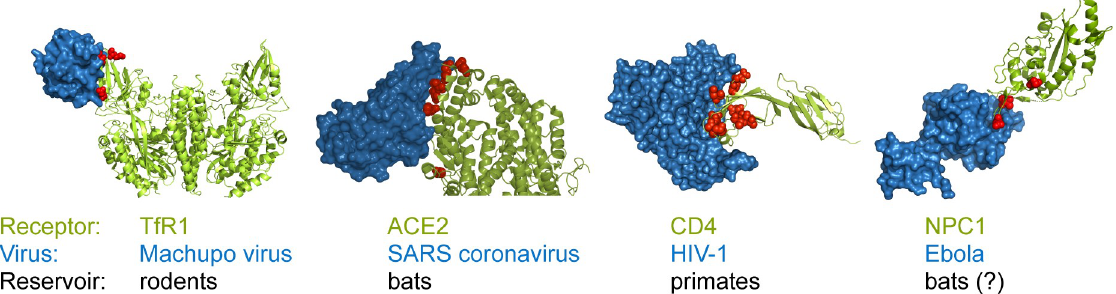
Fig 2. Receptors used by viruses are under positive selection at the host–virus interaction interface. The cocrystal structures are shown for four human cellular receptors (green) in complex with the surface glycoproteins (blue) of four viruses that use these receptors to enter cells. In each case, we analyzed the evolution of the receptor gene throughout the speciation of the animals that have served as long-term reservoirs for each of these viruses (rodents, bats, and primates in these four cases). In those analyses, amino-acid positions in the receptors that are evolving under positive selection (dN/dS > 1; red spheres) were identified that mapped directly to the interaction interface with the indicated viruses [93–96].These residue positions are rapidly evolving, which means that each species within these animal groups tends to encode unique amino acids at these positions. This explains why viruses often have to accumulate mutations in their surface glycoprotein that allow them to use the version of their receptor in a new species. Cocrystals shown are TfR1 (PBD: 3KAS [103]), ACE2 (PDB: 2AJF [104]), CD4 (PDB: 1RZJ [105]), and NPC1 (PDB: 5F1B [106]). The rendering of the CD4 cocrystal is from [92]. ACE2, angiotensin I converting enzyme 2; dN, rate of nonsynonymous substitution; dS, rate of synonymous substitution; NPC1, NPC intracellular